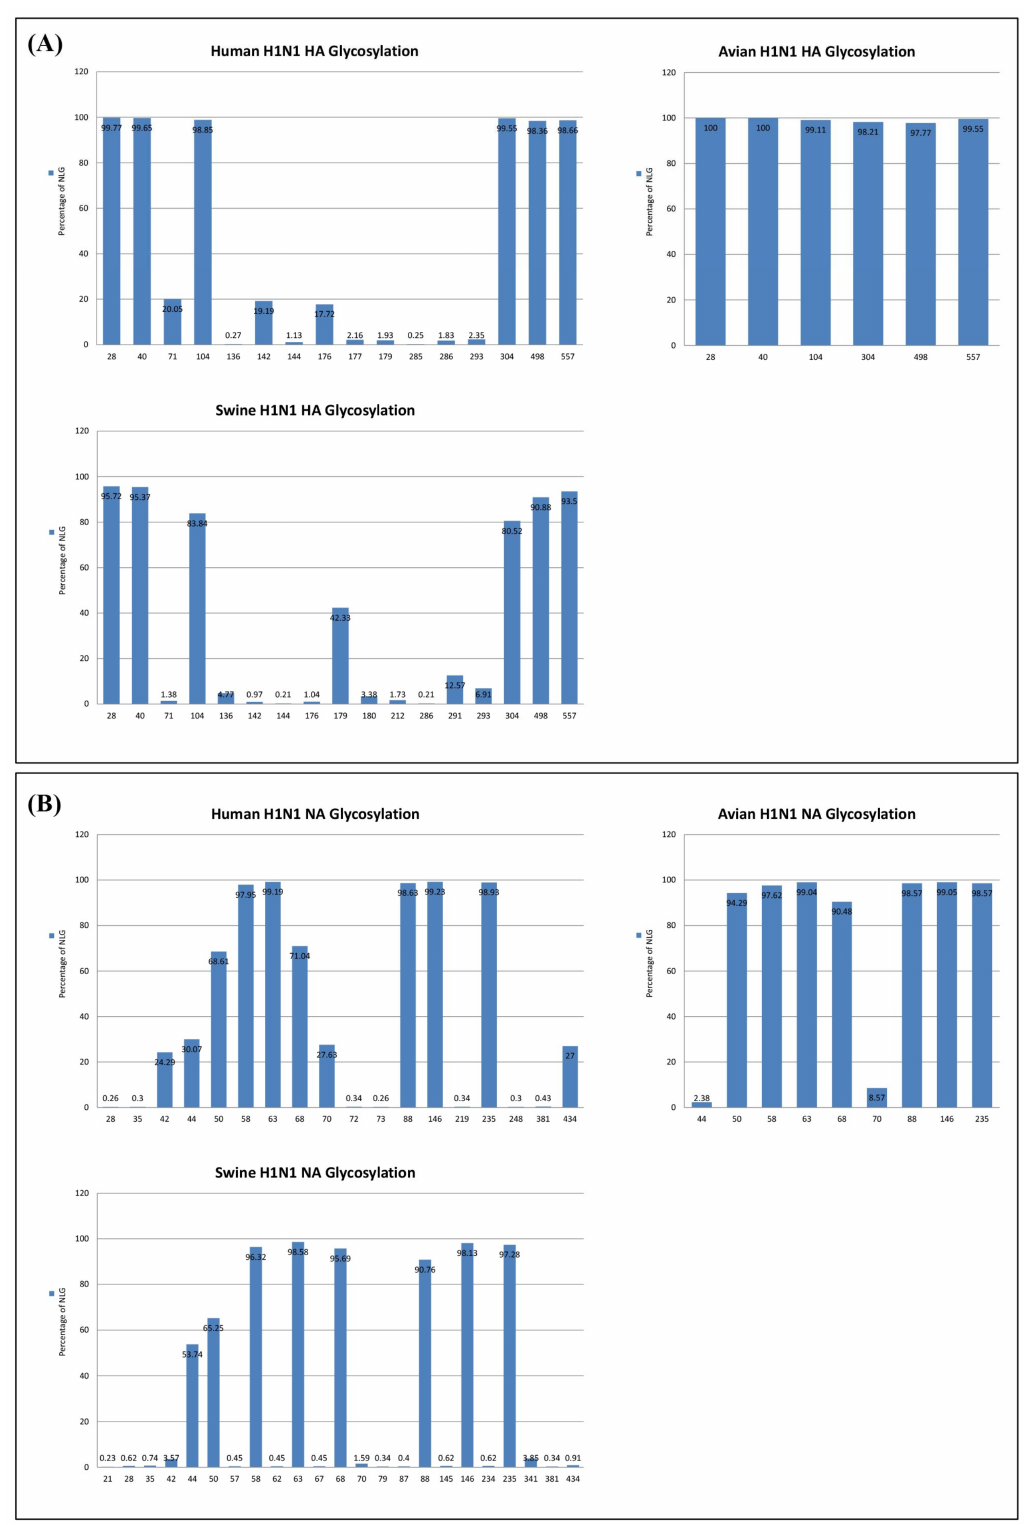
Figure 2. Total glycosylation sites predicted for H1N1 HA and NA. HA sequence analysis: 5785 HA sequences were isolated from humans, 224 from avian sources, and 1448 from swine sources ( A ). NA sequence analysis: 2986 sequences were from humans, 210 from avian sources, and 1764 sequences were from swine isolates ( B